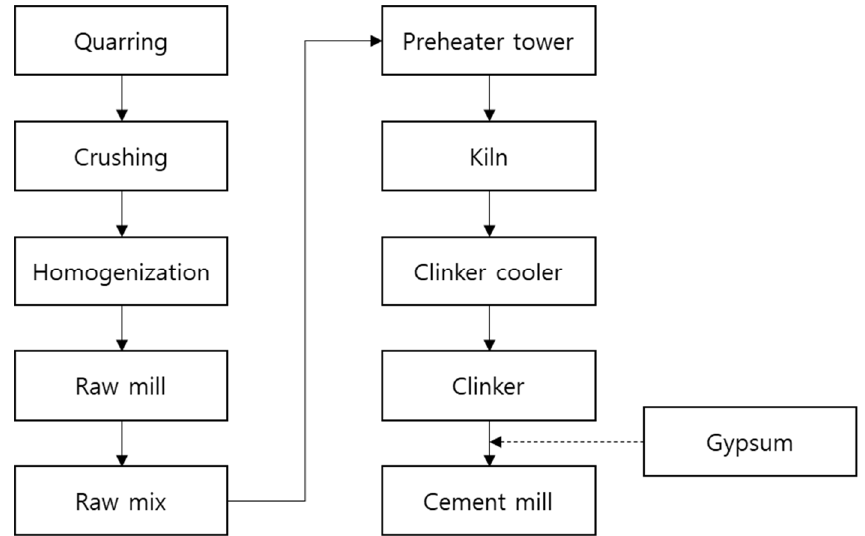
Figure 2. Supply chain of a typical cement plant.